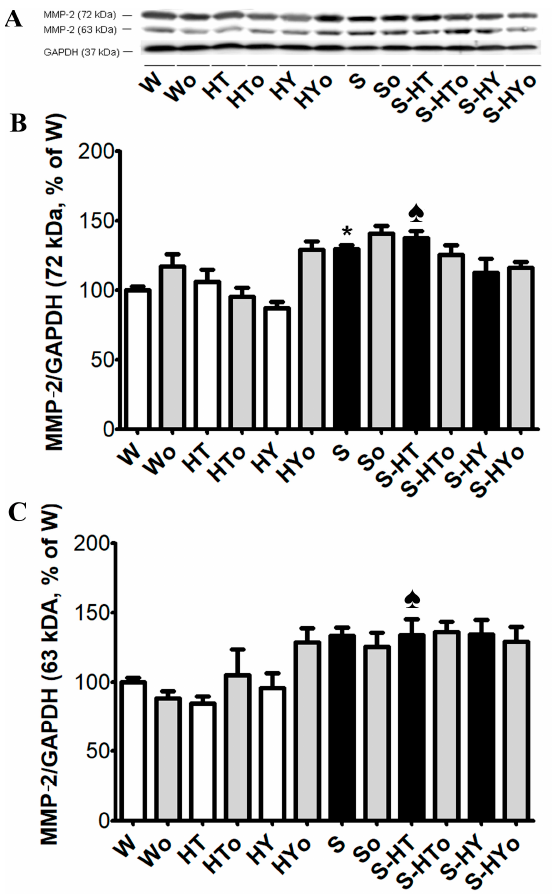
Figure 7. Protein abundance of myocardial matrix metalloproteinase-2 (MMP-2) normalized to glyceraldehyde-3-phosphate dehydrogenase (GAPDH) protein level in the male normotensive and hypertensive rats with altered thyroid status with or without feeding with Omacor. A 72 kDa pro-MMP-2 ( A , B ) and 63 kDa active MMP-2 ( A , C ) are shown. W—Wistar Kyoto euthyroid control rats; o—fed with Omacor; HT—hyperthyroid rats; HY—hypothyroid rats; S—spontaneously hypertensive rats; n = 6 in each group. Data are presented as means ± SD; * p < 0.05 vs. W; ♠ p < 0.05 HT vs. S-HT / HY vs. S-HY.